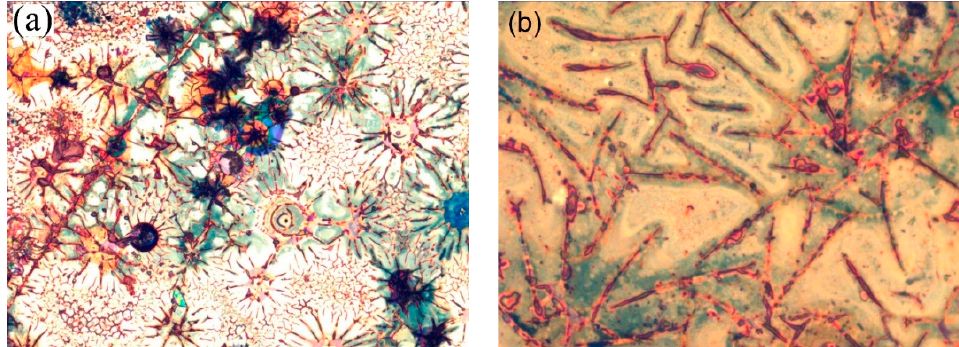
Figure 11. ( a ) 330 µm × 250 µm and ( b ) 130 µm × 105 µm LOM images of the electrode with a C/Cu ML in the delithiated SOC after 542 cycles, after washing, and after air exposure for 15 months. A color version of this figure can be viewed online.